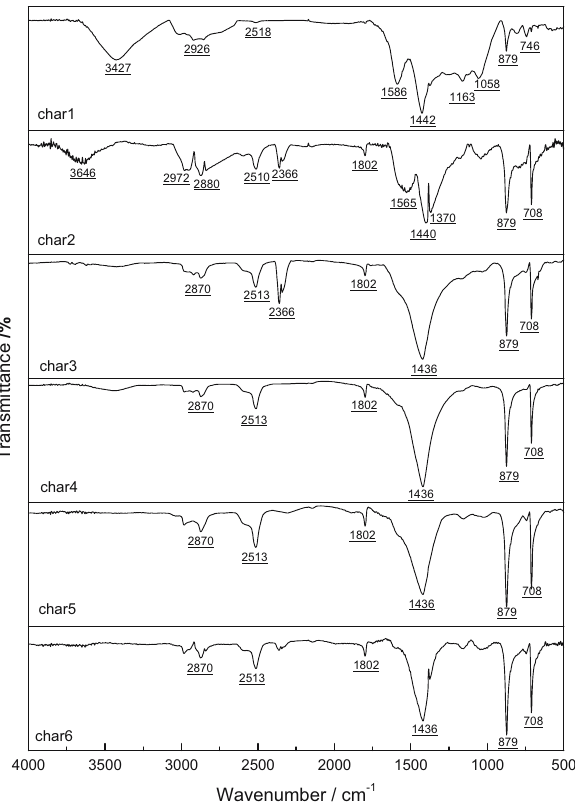
Figure 6: Semi - coke FTIR